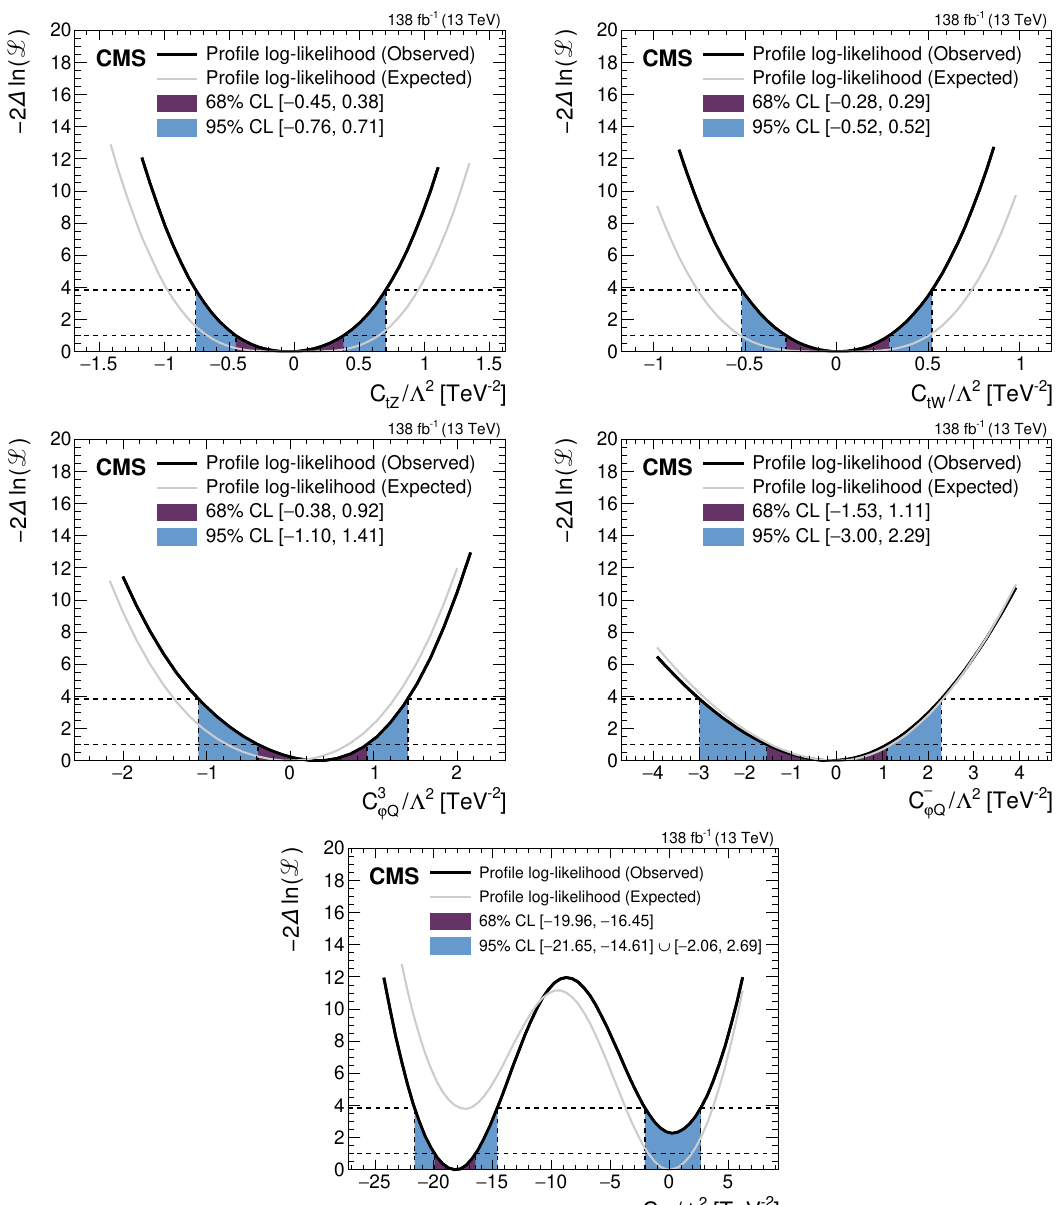
Figure 7 . Observed (thick black lines) and expected (thin gray lines) one-dimensional scans of the negative log-likelihood as a function of each of the five WCs, while fixing the other WCs to their SM values of zero. The 68 and 95% CL confidence intervals are indicated by the colored